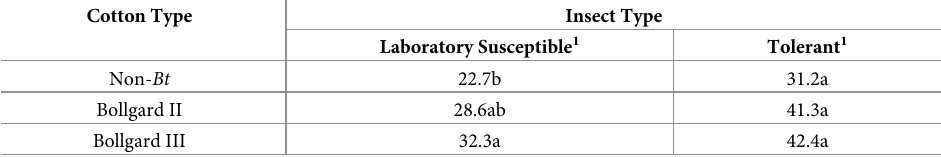
Table 1. Cumulative total H . zea eggs per 25 plants at final rating